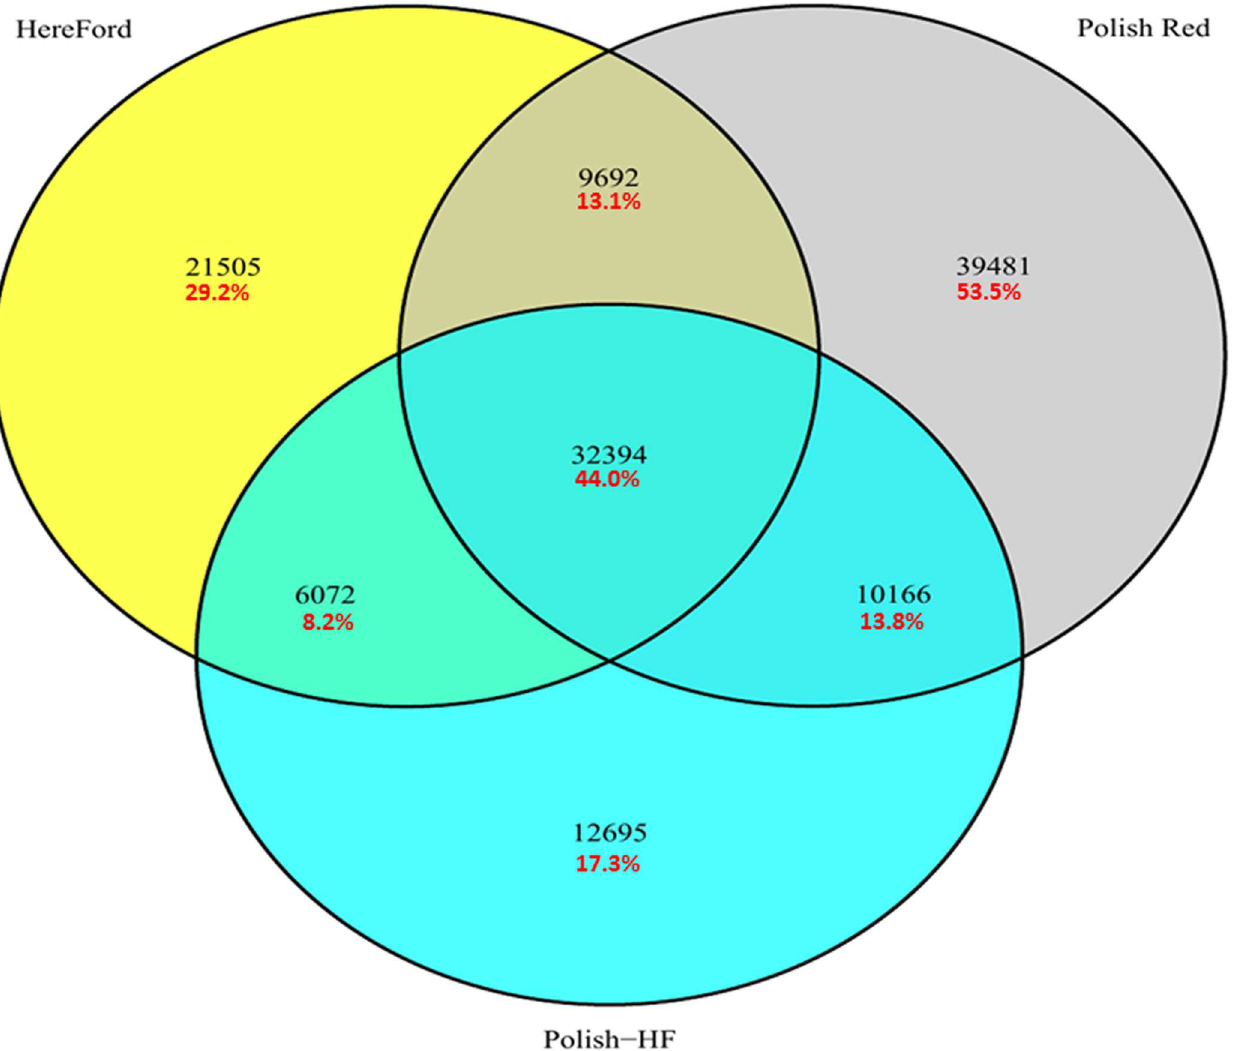
Fig 1. Venn diagram showing the number of SNPs segregating in Polish Red, Polish HF and Hereford cattle